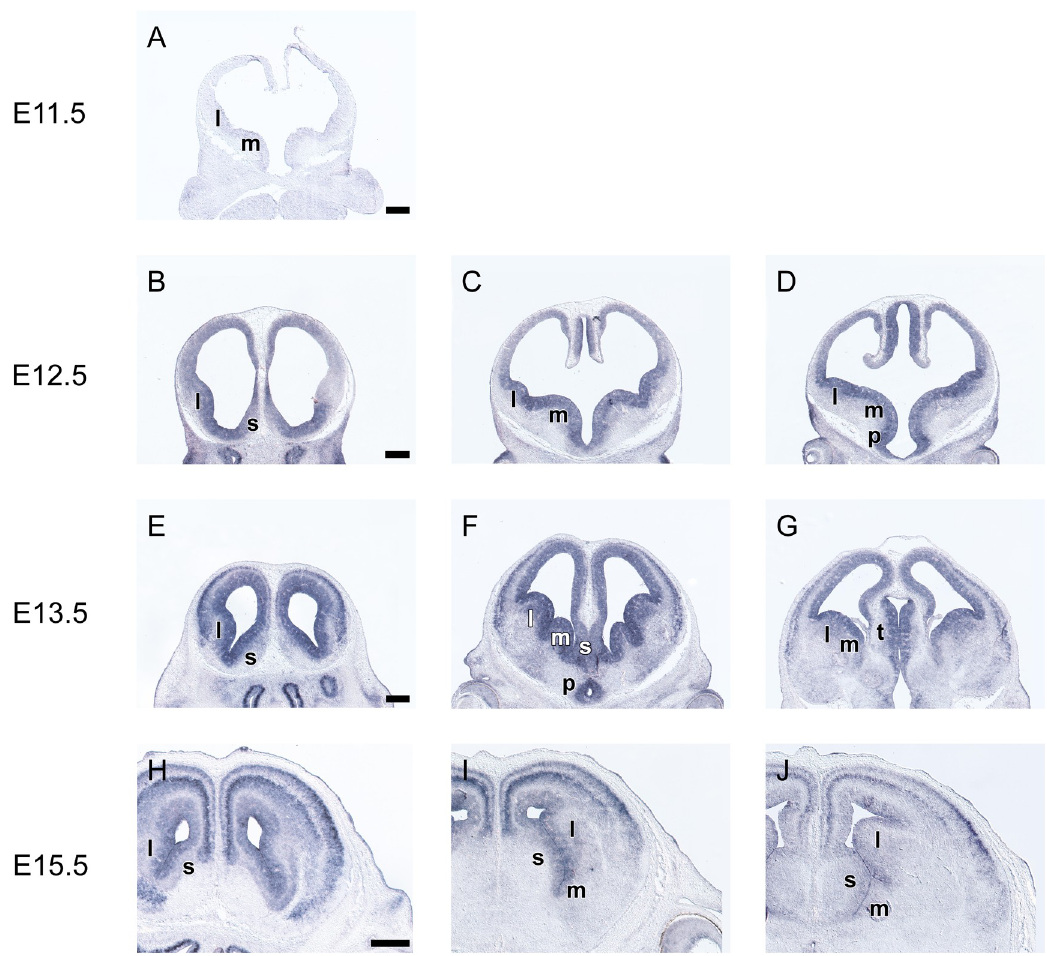
Fig 4. In situ hybridization on coronal sections through the embryonic telencephalon from rostral (left) to caudal (right) levels hybridized with an antisense RNA probe Grg3 at E11.5 (A), E12.5 (B—D), E13.5 (E-I) and E15.5 (H—J) m: MGE, l: LGE, l: LGE, s: septum. Scale: 250 μ